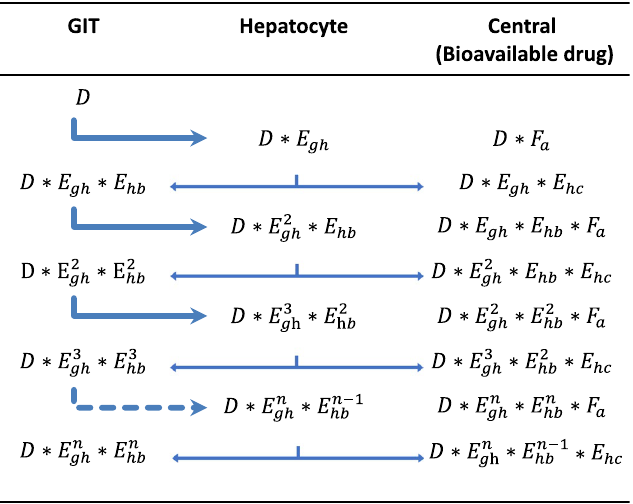
Table 2. Fractional method for arriving to an equation for oral drug bioavailability under enterohepatic reabsorption (EHR model). D : oral dose; E gh : hepatocyte extraction ratio; F a : fraction of drug that reaches the systemic circulation from the gut; E hb : fraction of intra-hepatocytic drug that is submitted to hepatobiliary secretion; E hc : fraction of intra-hepatocytic drug that reaches the systemic circulation. See Table 1 for